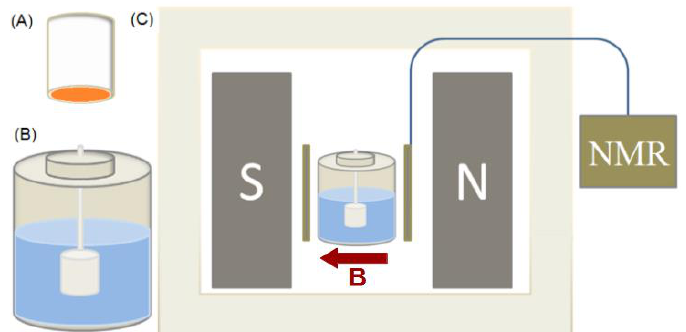
Figure 2. Schematic diagram of the experimental setup in NMR instrument ( B > 0). ( A ) Copper cylinder, ( B ) cell, and ( C ) experimental setup.